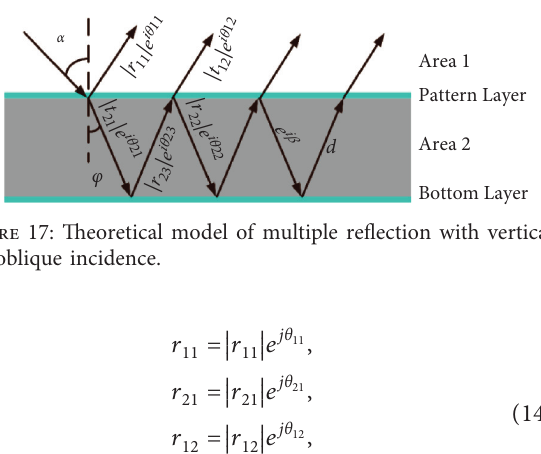
Figure 15: Absorptivity with different component combinations.